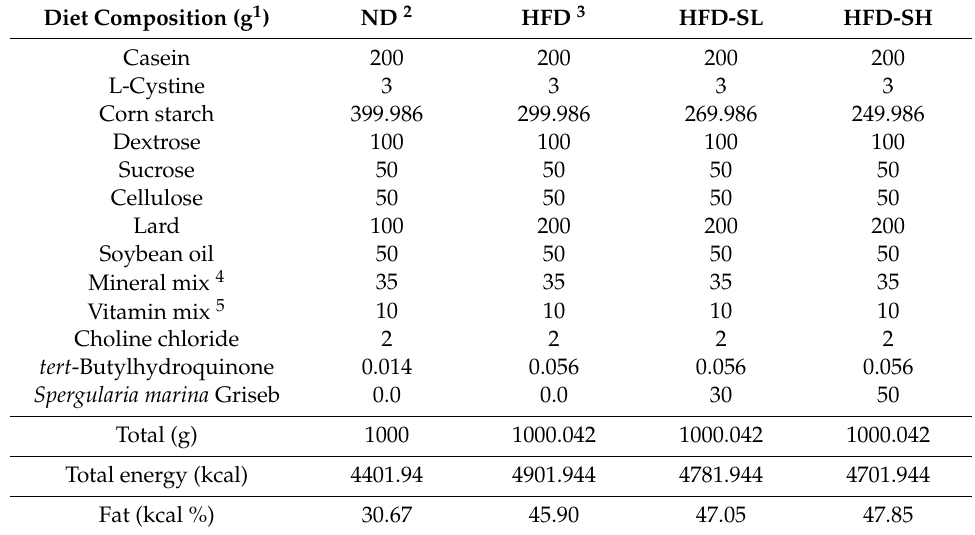
Table 1. Composition of experimental